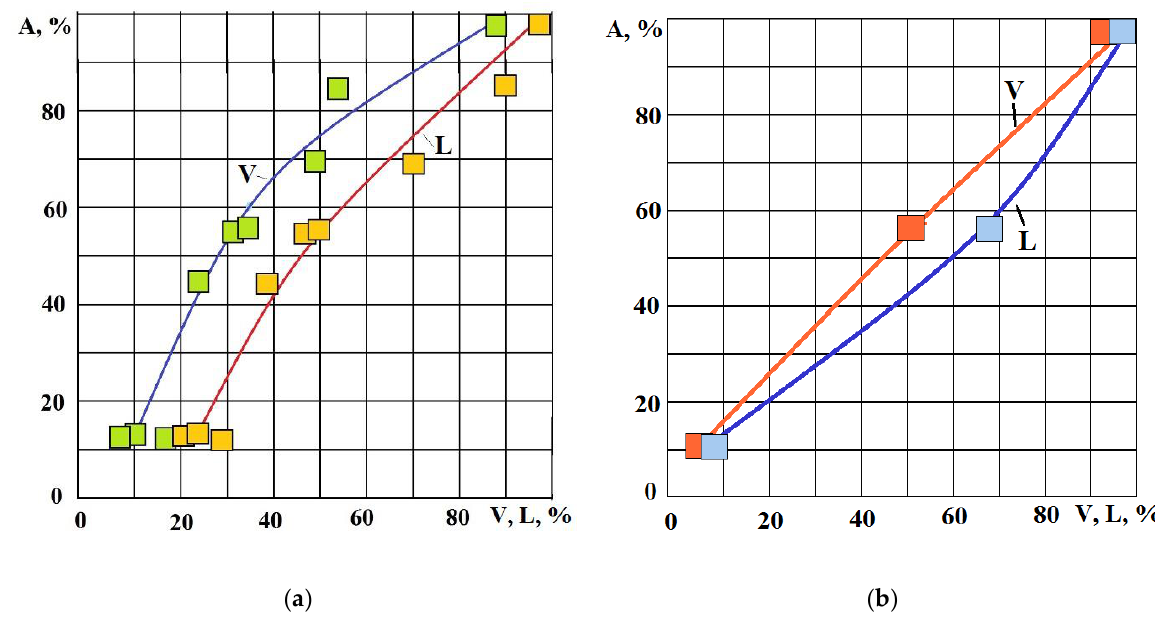
Figure 5. Dependence of the RMS amplitude of the AE signal in the range of 30 – 40 kHz on the volume of the removed material (V) and the depth of the hole (L): ( a ) — with variations in discharge energy, pulse duration and frequency; ( b ) — with variations in discharge energy only. On the graphs, all values along the axes are indicated as a percentage of the maximum values.